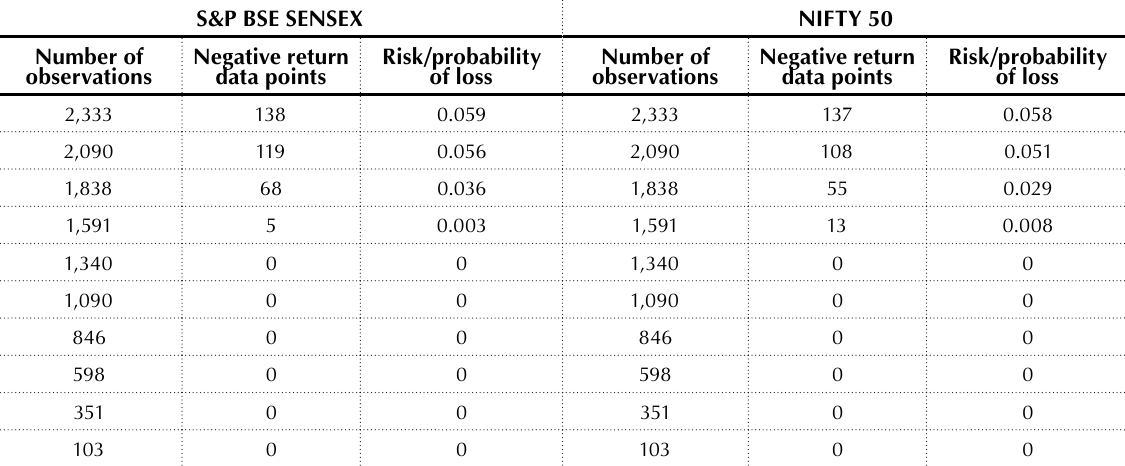
Table 21 (cont.). Rolling period risk and return behavior of SENSEX and Nifty